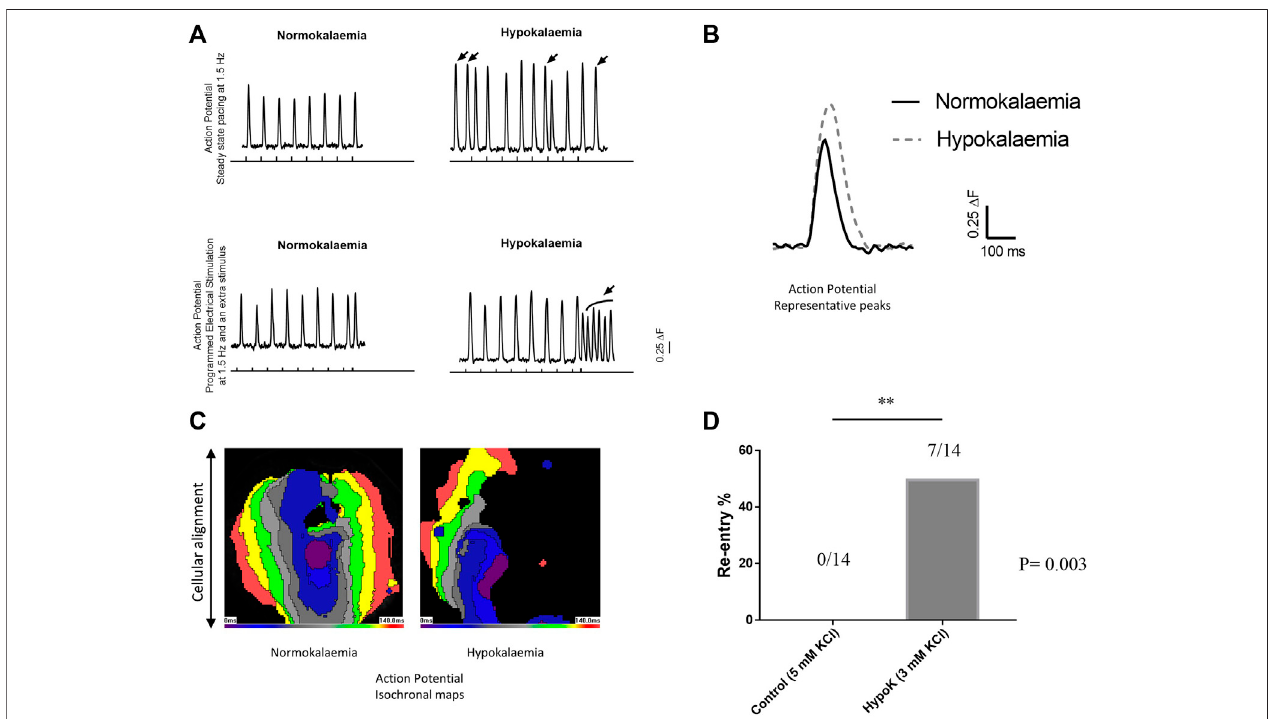
FIGURE2|(A) Upperpanelshowsthesteadystatepacingat1.5 Hzandthebottompanelshowsprogrammedelectricalstimulation.Theperpendicularlinesalong thex-axisarethepacingsfrom theexternalstimulator.Arrowsoverthepeaksshowprematureactionpotentials (APs). (B) RepresentativeAPtracingsofnormokalaemic and hypokalaemic samples. (C) Isochronal maps of the normokalaemic sample (left panel) with normal AP propagation from the center towards the edges and the hypokalaemicsample (rightpanel) showingspiralAPpropagationcirculatingthecenter. (D) Re-entrypercentagesofnormokalaemicandhypokalaemicsamples.